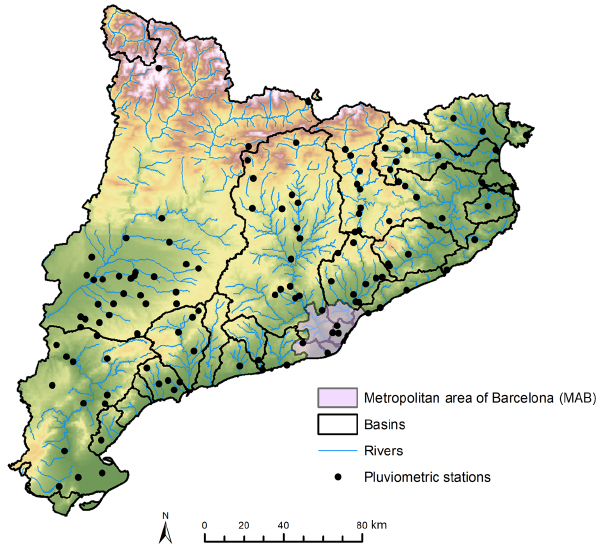
Figure 1. Map of Catalonia showing the aggregated basins, the metropolitan area of Barcelona (MAB), the main rivers and the plu- viometric stations